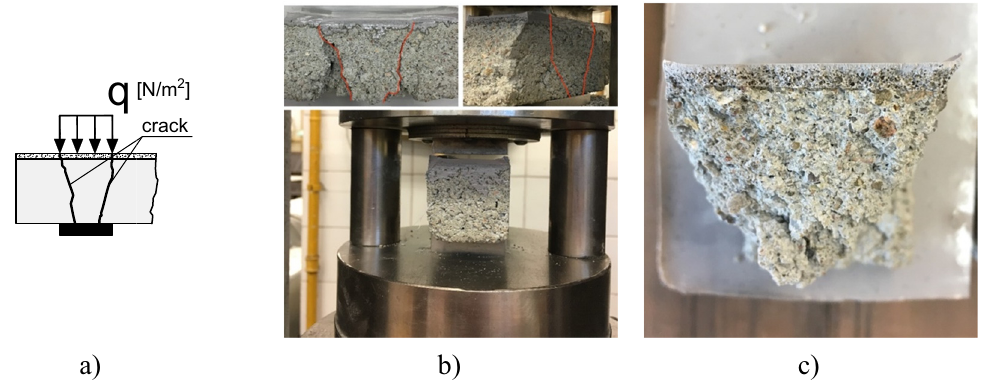
Figure 6: Compression strength test: ( a ) scheme of the test; ( b ) view of a specimen during the test with crack propagation highlighted with the red lines; ( c ) destroyed specimen.